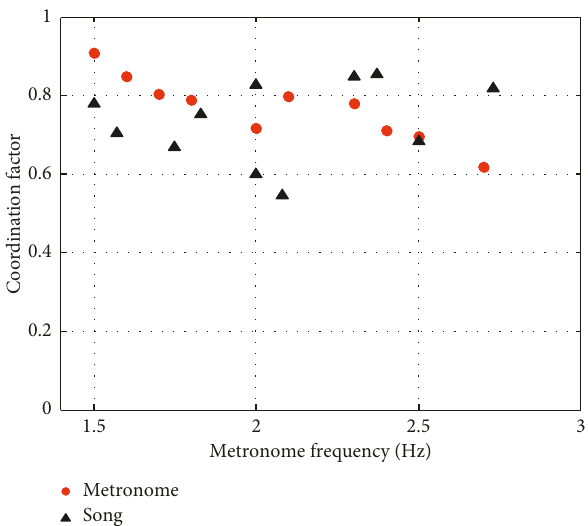
Figure 41: Comparison of the coordination factors for auditory stimuli—metronome and